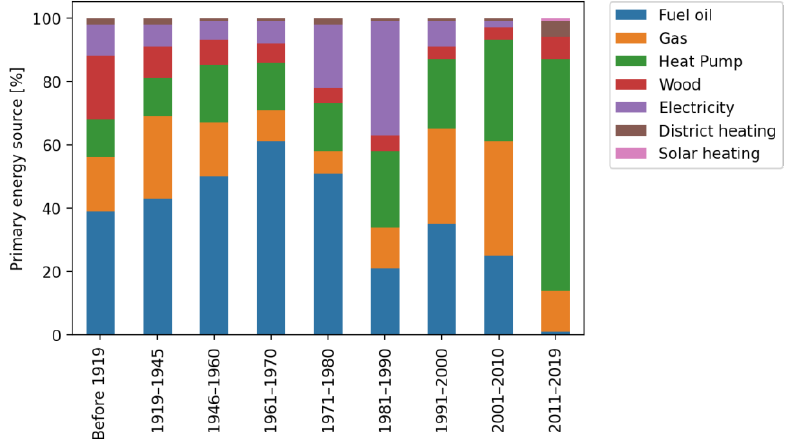
Figure 1. Primary energy source distribution by period of construction for single-family houses.